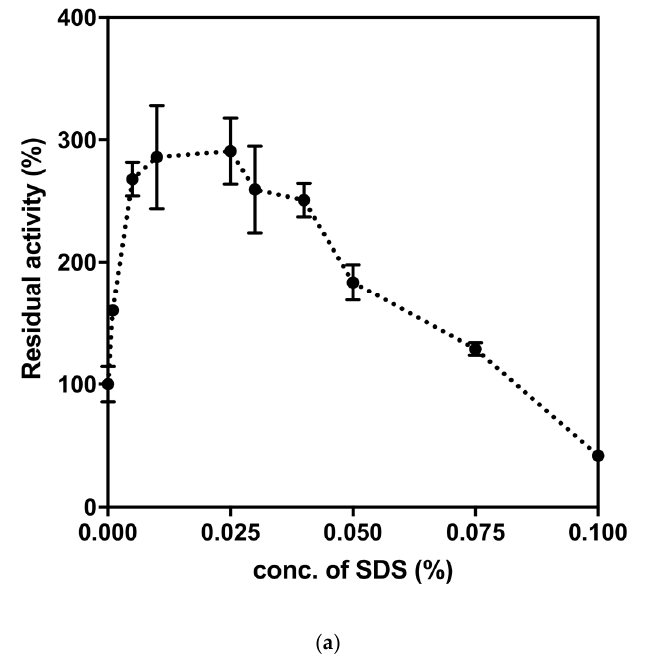
Table 3. Kinetic analysis of Sso Pox3Mut and 4Mut on nerve agents.